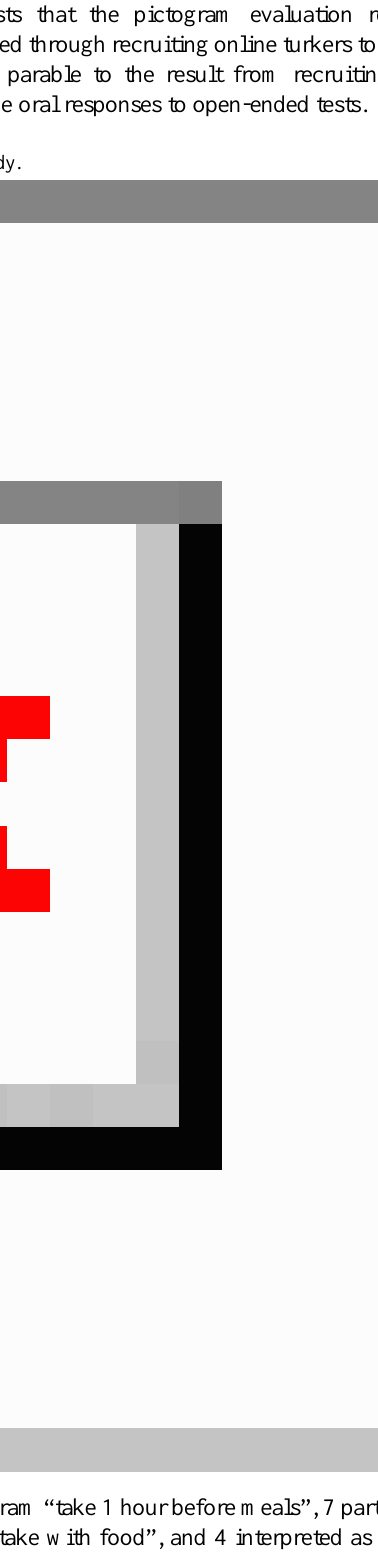
Content Analysis of Common Misinterpretations Figure 7 lists common misinterpretations (similar misinterpretations given by at least 2 turkers) for 9 pictograms. The number in the parentheses shows how many turkers described the pictogram in a similar way. For instance, in